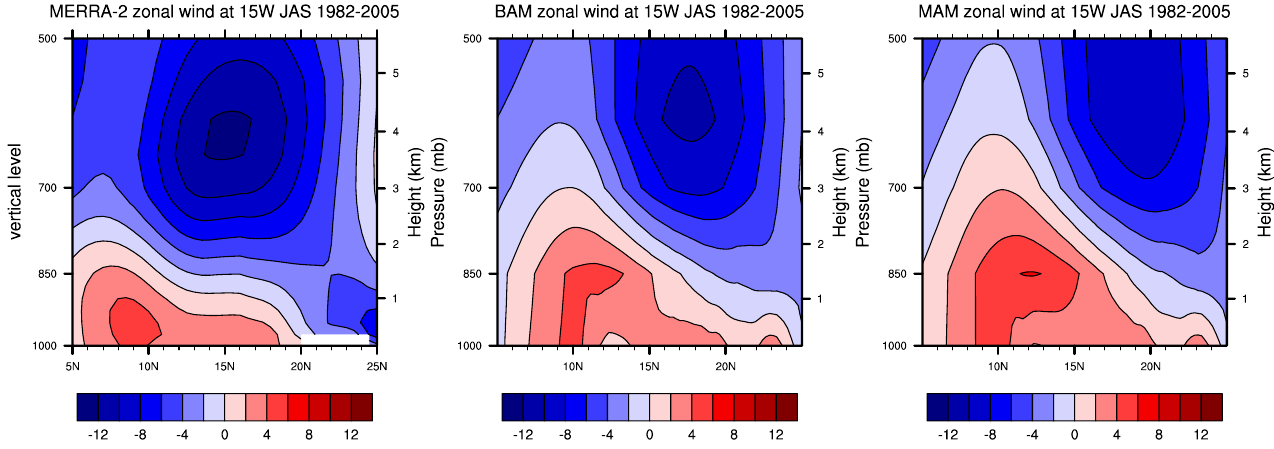
Figure 4. Vertical and latitudinal distribution of the AEJ (zonal wind) over the North Atlantic at 15 W. These are calculated using July, August, and September seasonal averages from 1982 to 2005 for ( left ) MERRA-2, ( middle ) BAM, and ( right ) MAM.